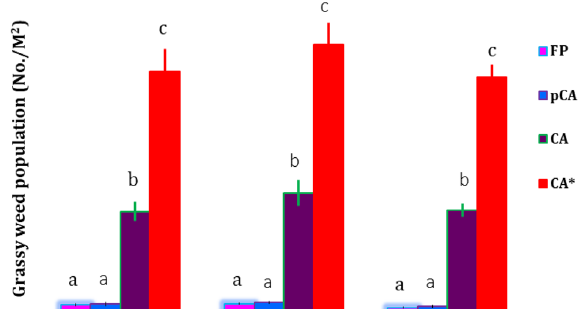
Figure 6. Grassy weed population in fields of different agricultural production systems. Bars with different letters indicate significant differences among production systems (LSD; P < 0.05). * CA-based production system with ZTDSR-mustard (ZT)-spring maize (ZT) sequences.